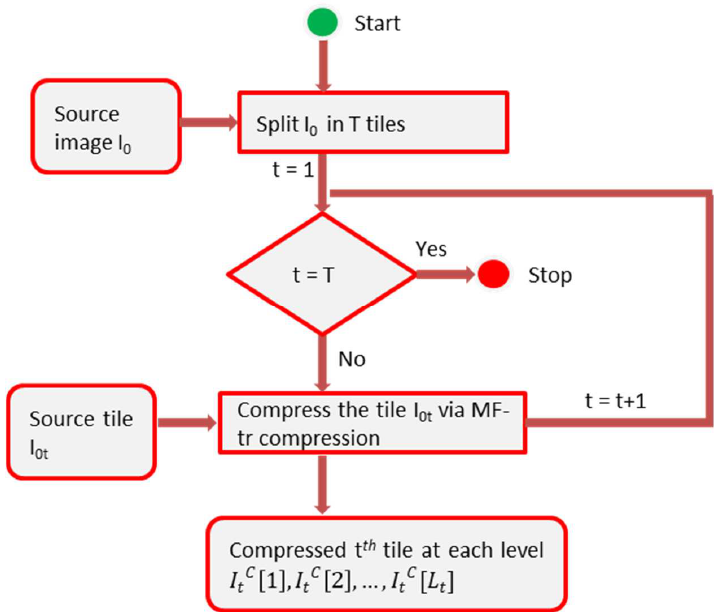
Figure 2. Flow diagram of the MIMF-tr image compression algorithm.